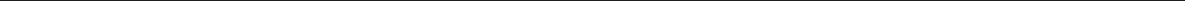
Fig. 5 Functionally important residues in the UDP-GalNAc-binding cavity. a 3D structural model of PGAP4 with three TMDs in molecular surface display method. (Left) The whole structure of PGAP4 Δ N with UDP-GalNAc. (Right) The model rotated by 90° and cut to visualize the active site. Carbon, nitrogen, oxygen, sulfur, and hydrogen are shown in gray, blue, red, yellow, and white, respectively. b Enlarged view of PGAP4 Δ N around UDP-GalNAc. Residues important for the activity are shown by sticks. c , d Western blotting ( c ) and immuno fl uorescence imaging ( d ) of various PGAP4 mutants. pME- hPGAP4-3HA-bearing WT or mutant sequences was transiently transfected into 3BT5-PGAP4-KO cells. c Representative data from two independent experiments. GAPDH, loading control. d GPP130, the Golgi marker. Scale bars: 10 µ m. e Functional analysis of PGAP4 mutants. 3BT5-PGAP4-KO cells were transiently transfected with pME-hPGAP4-3HA for T334A mutant or pTK-hPGAP4-3HA harboring weak promoter for other mutants. Cells were stained with T5 mAb. Dotted lines, background staining. In lower panels, blue and red lines indicate PGAP4 WT and mutants, respectively. Quantitative data, mean fl uorescence intensity ( ± SD) from three independent experiments ( n = 3). * p < 0.05; ** p < 0.005; *** p < 0.0005. e Statistical analyses were done by unpaired Student ’ s t -test. See also Supplementary Fig. 5 and